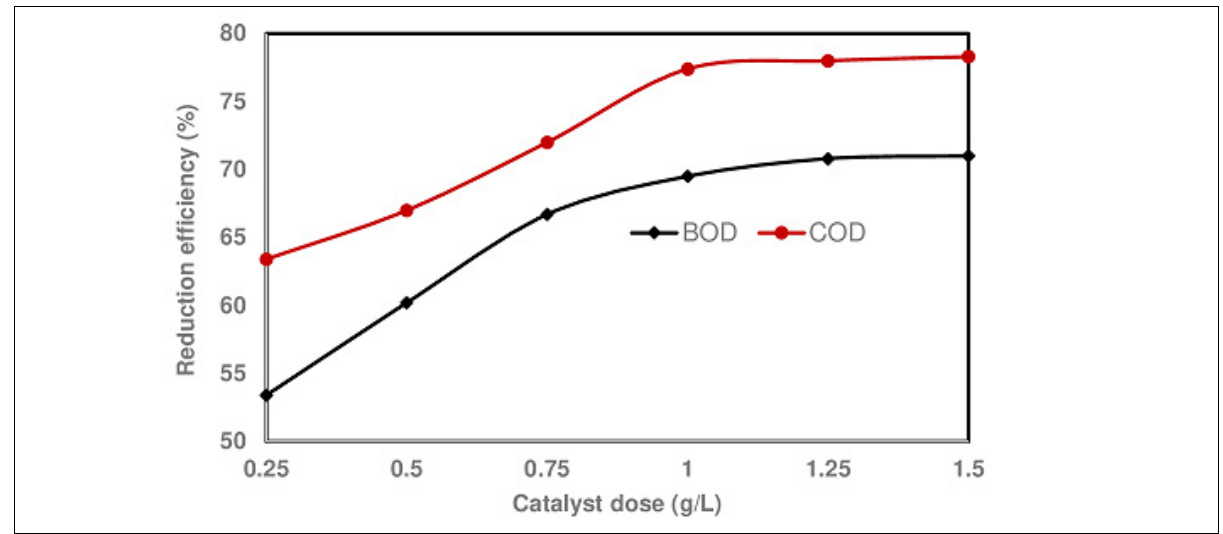
) and chemical oxygen demand 5